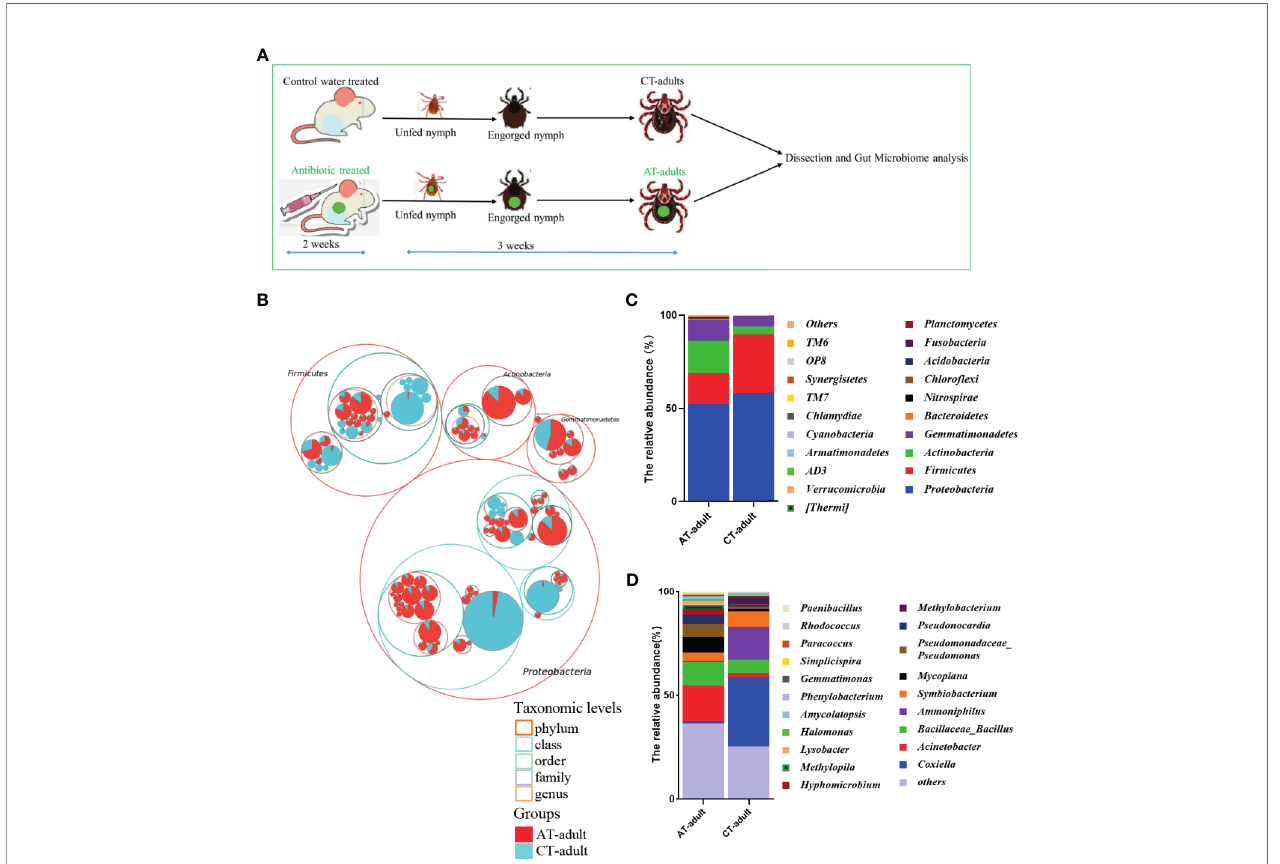
FIGURE 1 | Antibiotics use on mice affects the gut microbiota community of H. longicornis . (A) The experimental work fl ow for microbiome analysis. Nymphs were fed on an antibiotic cocktail- treated or water control mice to generate AT adults and CT adults, respectively. The 2-week scale represents the time it takes to build an antibiotic-treated mouse model. The 3-week scale represents the time it required to obtain the newly molted adult ticks from the unfed nymphs in this study. The green dot represents perform antibiotic treatment. (B) Taxonomic differences are based on 16S rRNA sequencing. Taxonomic composition visualized by circular packing. The largest circles represent phylum level, and the inner circles represent class, family, and genus. The circle sizes represent the mean relative abundance of the taxa. The taxa were colored by sample groups (red for AT adults and blue for CT adults), whereas the area of the group corresponded to the mean relative abundance of the taxa in each group. (C, D) Total gut bacterial relative abundance at the taxonomic rank of phylum (C) and genus (D) of CT adults and AT